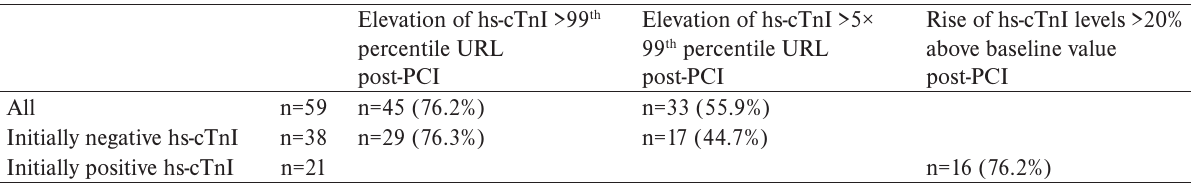
Table 2. Elevation of hs-cTnI in the CAG + PCI subgroup.